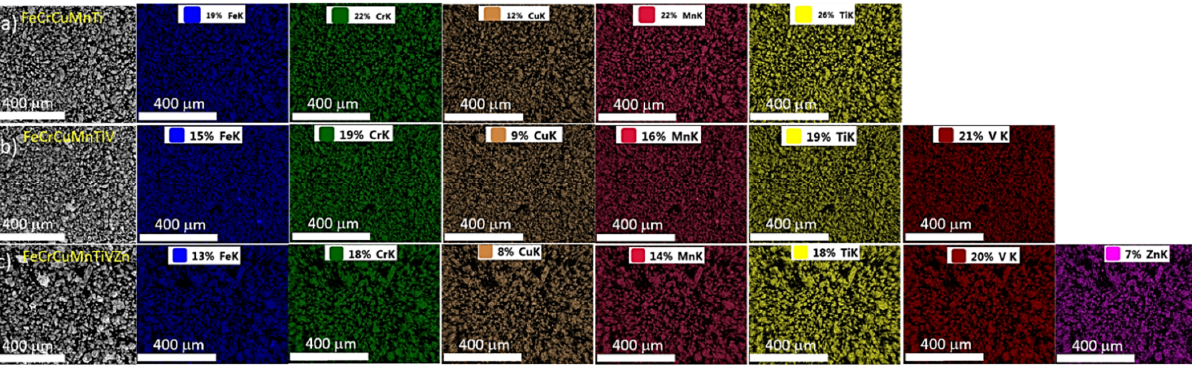
Figure 5. HRSEM elemental overlay map of three developed high entropy alloys: ( a ) FeCrCuMnTi; ( b ) FeCrCuMnTiV; and ( c ) FeCrCuMnTiVZn.